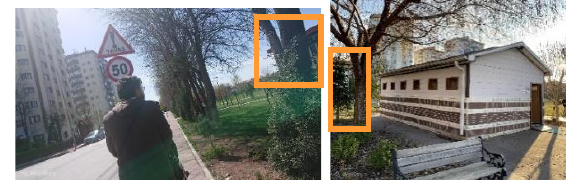
Figure 17. Two out of three missed images for TB:5 with Th:50 °, the target can be seen very slightly (Image ids: xfUfnxDjtAYXpEmytJ8FhA and tKo5Yr0hn0zTRv5j5YGRmA Figure 19. A box plots of distance difference from computed respectively) and original image location of 237 images obtained via Mapillary API.